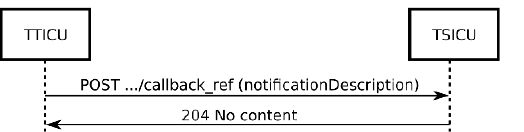
Figure 9. Flow of the subscription creation procedure.